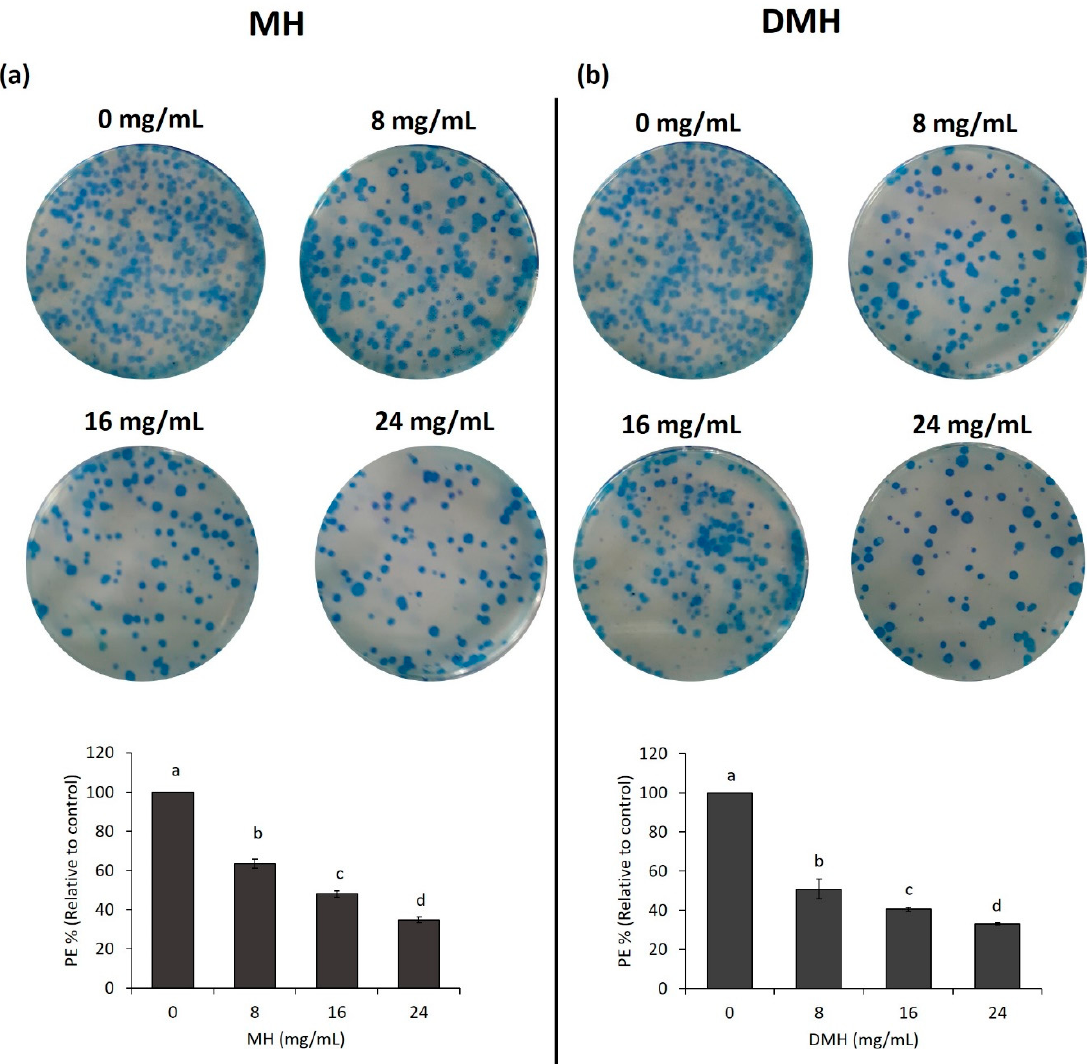
Figure 7. MH ( a ) and DMH ( b ) inhibits colony formation ability by MH and DMH in HCT-116. Cells were treated with different concentrations (0, 8, 16 and 24 mg/mL) of MH or DMH for 48 h. After treatment the cells were seeded at a density of 1000 cells/well for 12 days. The formed colonies were fixed with 70% ethanol and stained with methylene blue for count colonies. The results are expressed as a % of plating efficiency (PE) relative to control. The values are expressed as the mean of three independent experiments ± SD. The different superscript letters (a–d) in each bar indicate significant difference ( p < 0.05).